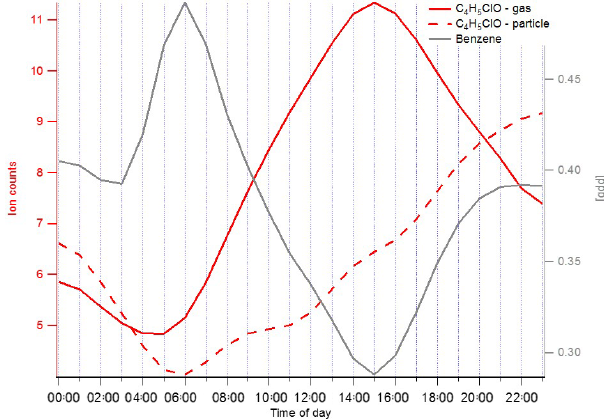
Figure 12. Mean campaign diurnal profiles of benzene (grey) and CCA in the particle (dashed red) and gas phases (solid red).